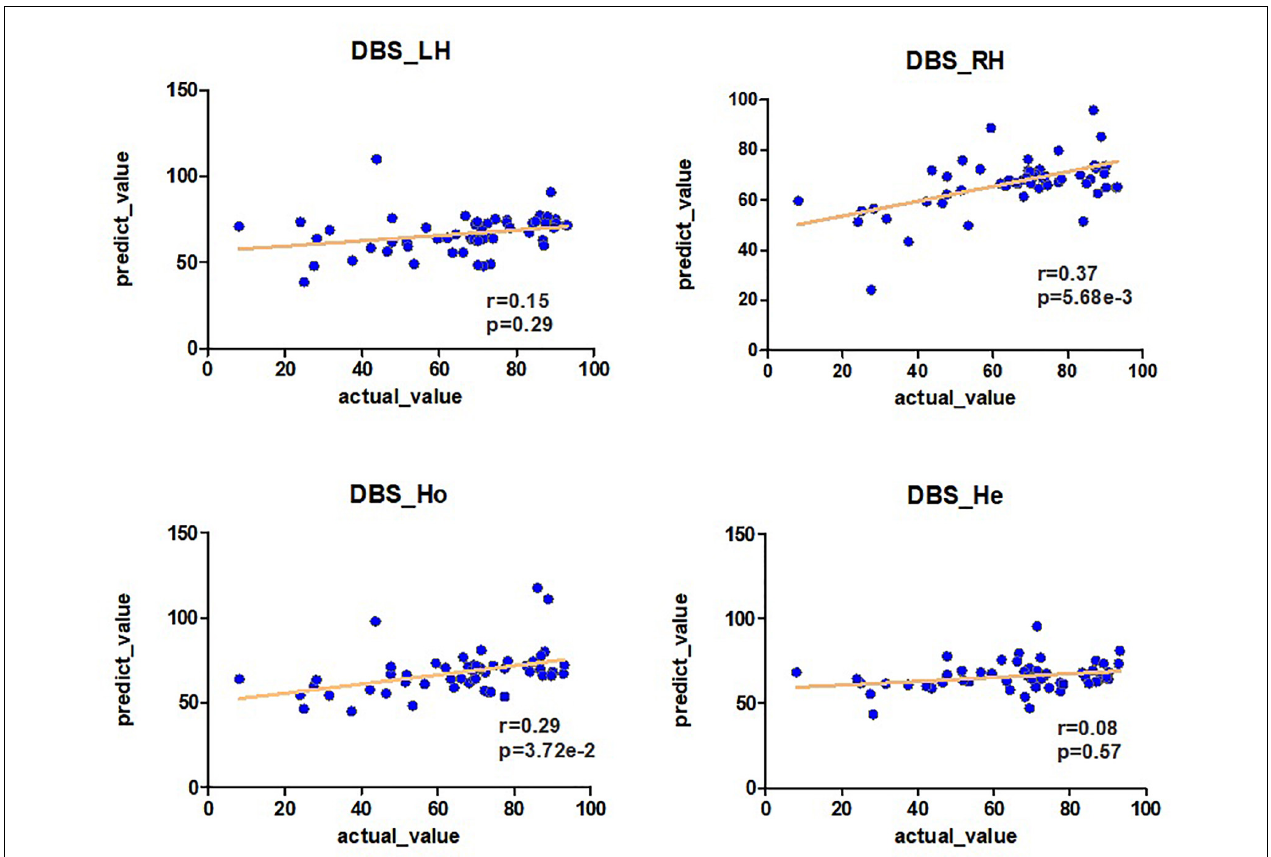
FIGURE 2 | The predictability of brain connection on the DBS off-rate. Pearson analysis is used between the off-rate of DBS and the prediction of brain connections LH, RH, Ho, and He ( r , p ). The prediction is obtained by the Ridge model.